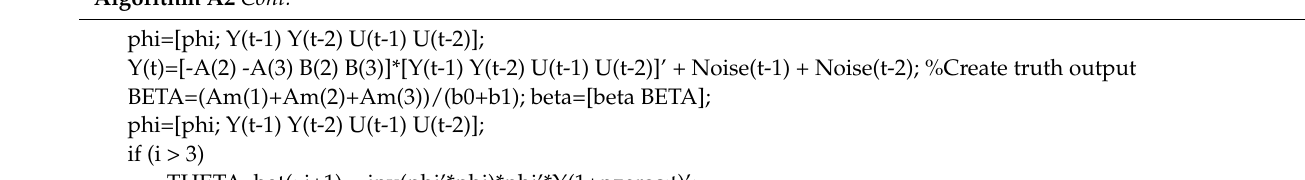
Algorithm A2 Cont.